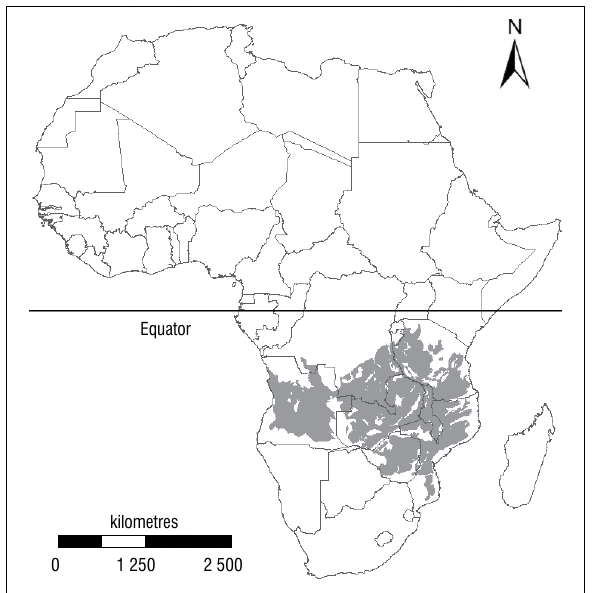
kilometres 0 375